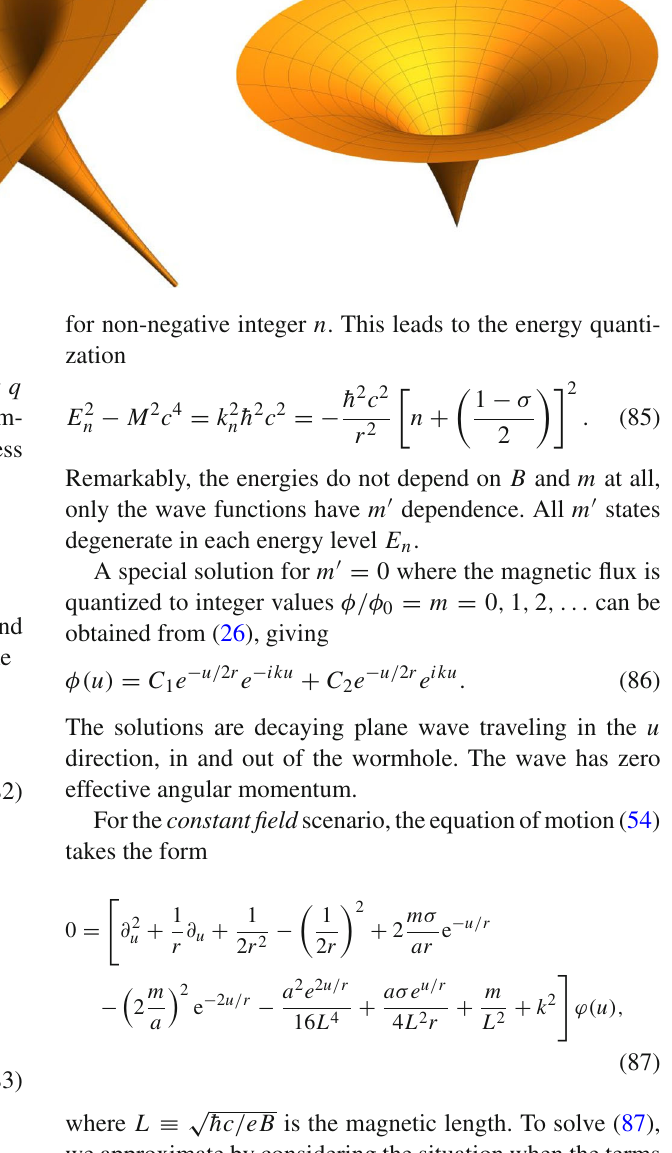
Fig. 2 Geometric structure of a Beltrami and elliptic wormhole surface. The Hilbert horizon(s) of Beltrami and elliptic wormhole is (are) at u H = r log[2 r / a ]